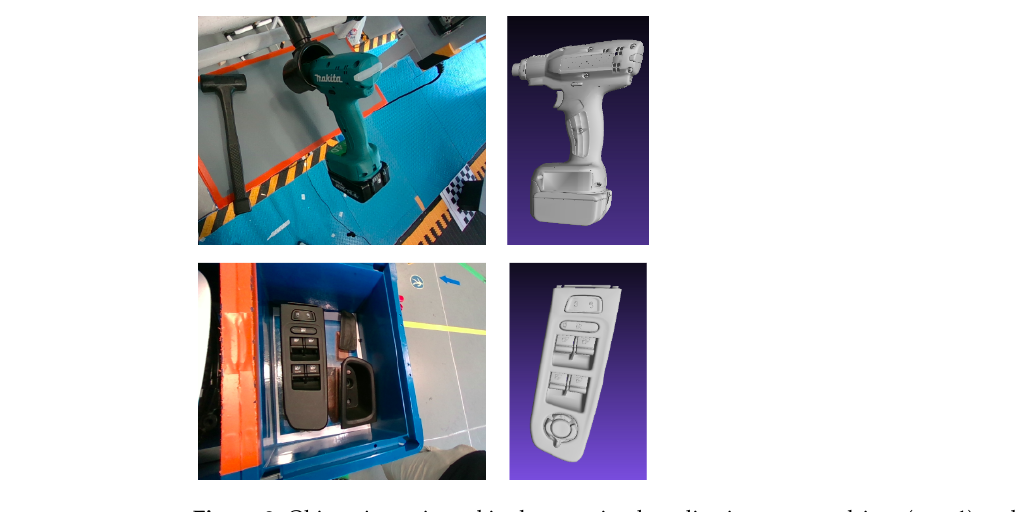
Figure 2. Objects investigated in the examined application, a screwdriver (row 1) and a black window control panel (row 2). The first column presents sample images of the objects in the industrial environment, while the second column presents the respective 3D object